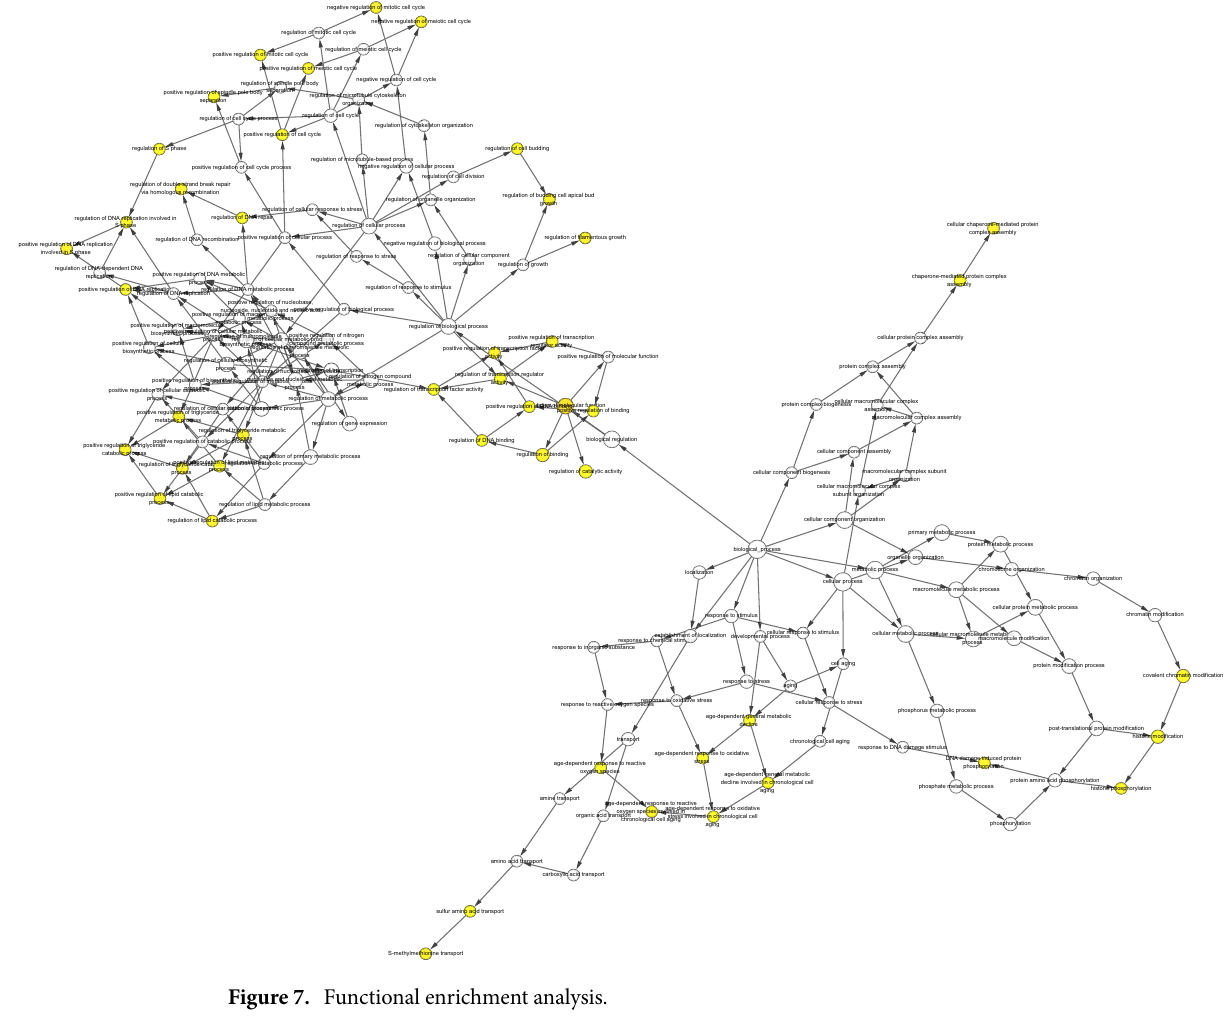
Figure 7. Functional enrichment